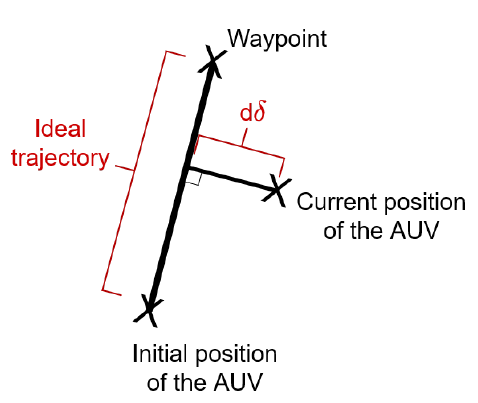
Figure 9. Definition of the ideal trajectory and the distance error d δ